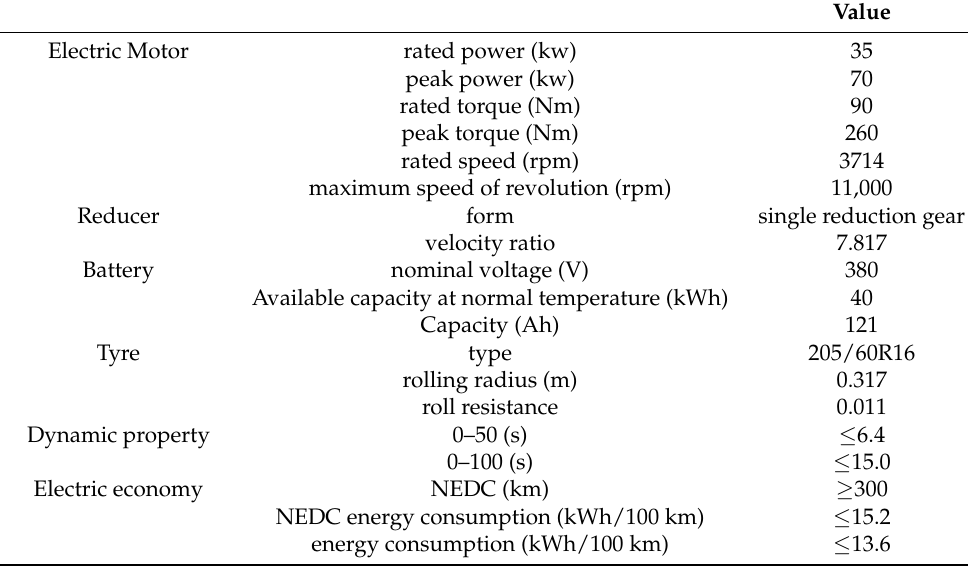
Table 2. Performance Parameter of the